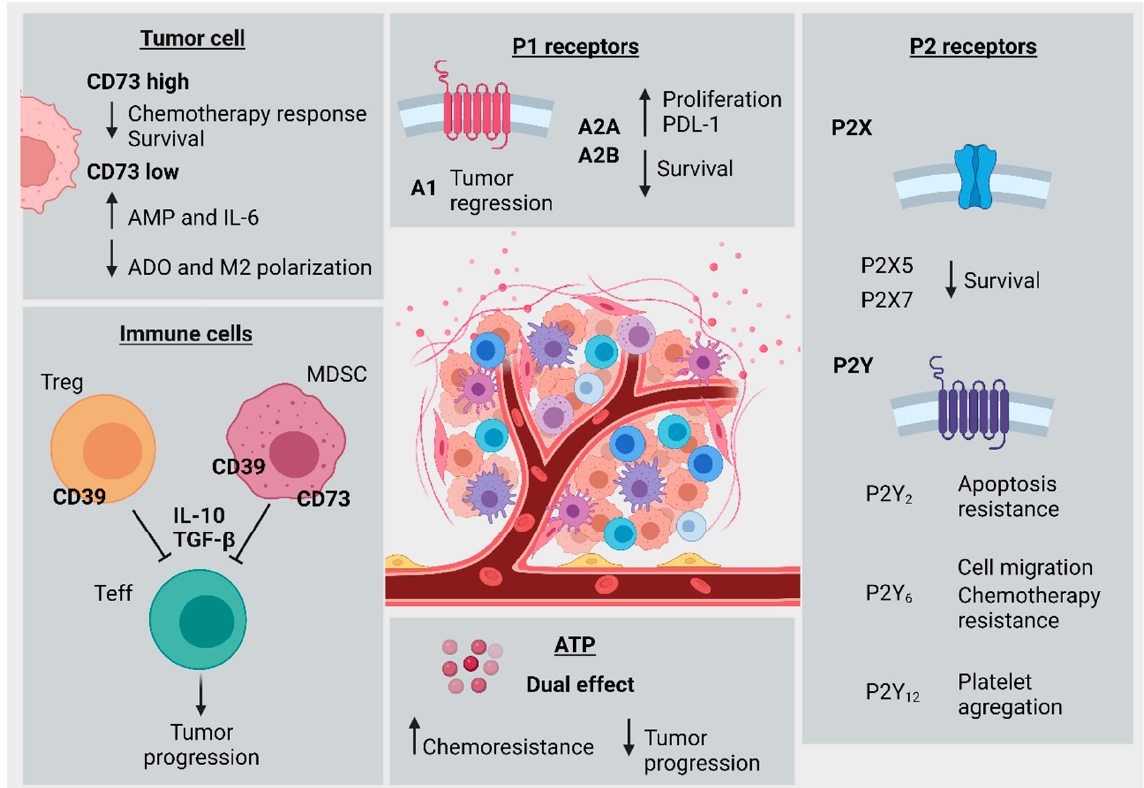
Figure 3. Hallmarks of purinergic signaling in colorectal cancer progression. Tumor cell ( top left ): high levels of CD73 expression were associated with decreased chemotherapy response and patient survival. Low CD73 expression was associated with decreased ADO levels and impairment of M2-macrophage polarization, along with increased AMP and IL-6 levels. Immune cells ( bottom left ): CD39 expression in T regulatory cells or MDSCs was associated with T effector cell inhibition by cytokines like IL-10 and TGF- β , leading to subsequently increased tumor progression. Extracellular ATP ( bottom middle ): ATP levels have a dual effect, and are associated both with increased chemore- sistance and, alternatively, reduced CRC cell viability and proliferation. P2 Receptors ( bottom right ): P2X5 and P2X7 were both associated with decreased patient survival. P2Y 2 was associated with in- creased resistance to apoptosis, P2Y 6 was associated with increased cell migration and chemotherapy resistance, and P2Y 12 was associated with increased platelet aggregation. P1 Receptors ( top right ): A1 receptor was correlated with tumor regression, A2A and A2B were correlated with increased PD-L1 expression and cellular proliferation, and both were corresponded to decreased patient survival. Taken together, these studies indicate that purinergic signaling is active in both tumor and tumor-associated immune cells. The CD39/CD73 ectonucleotidase axis and